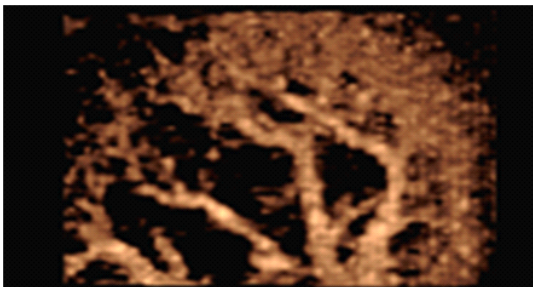
Figure 3 Subharmonic contrast enhanced ultrasound of the kidney details macro- and micro-circulation of the renal parenchyma in a three- dimensional rendering